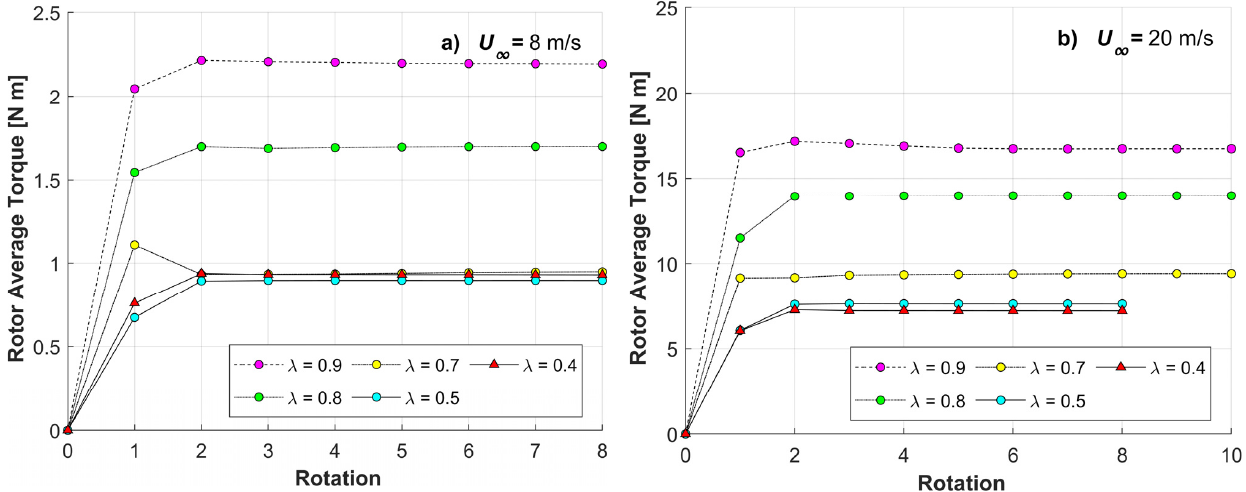
Figure 7. Average Rotor Overall Torque at Different λ for ( a ) U ∞ = 8 m/s and ( b ) U ∞ = 20 m/s, Using the 2D Model of the Present Study. Note: Rotor Average Torque = 1